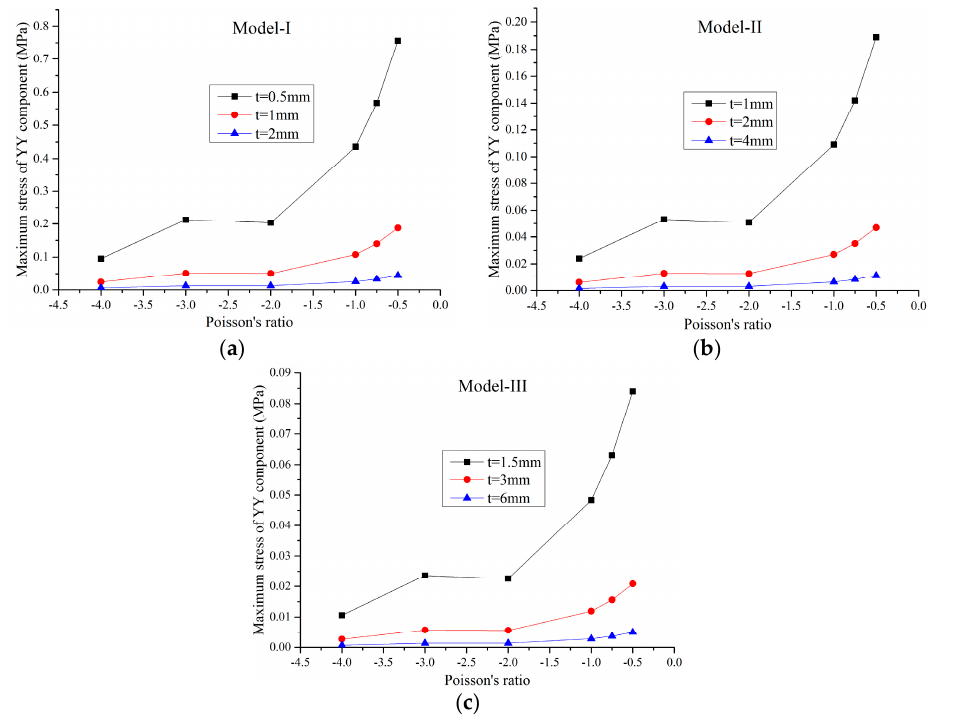
Figure 4. Maximum stress of the YY component versus the Poisson’s ratio: ( a ) Model-I; ( b ) Model-II; ( c ) Model-III.